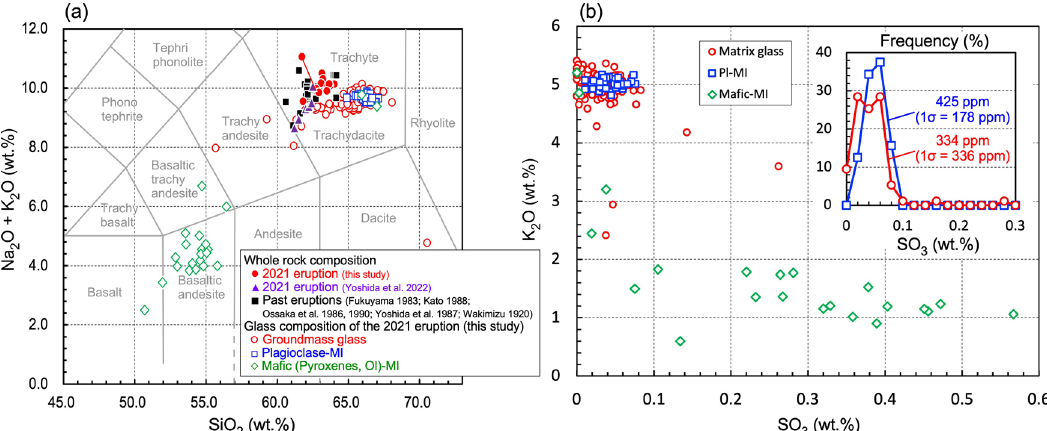
Fig. 3 Chemical compositions of the 2021 FOB products. a Whole-rock and glass (groundmass and melt inclusion, MI) major element compositions of the 2021 FOB products. Dots connected with a line indicate different portions of the same pumice clast. Black symbols indicate products of previous FOB eruptions. b Groundmass and MI glass SO 3 compositions. Inset fi gure indicates the frequency of the composition for groundmass (red) and MI glasses (blue).